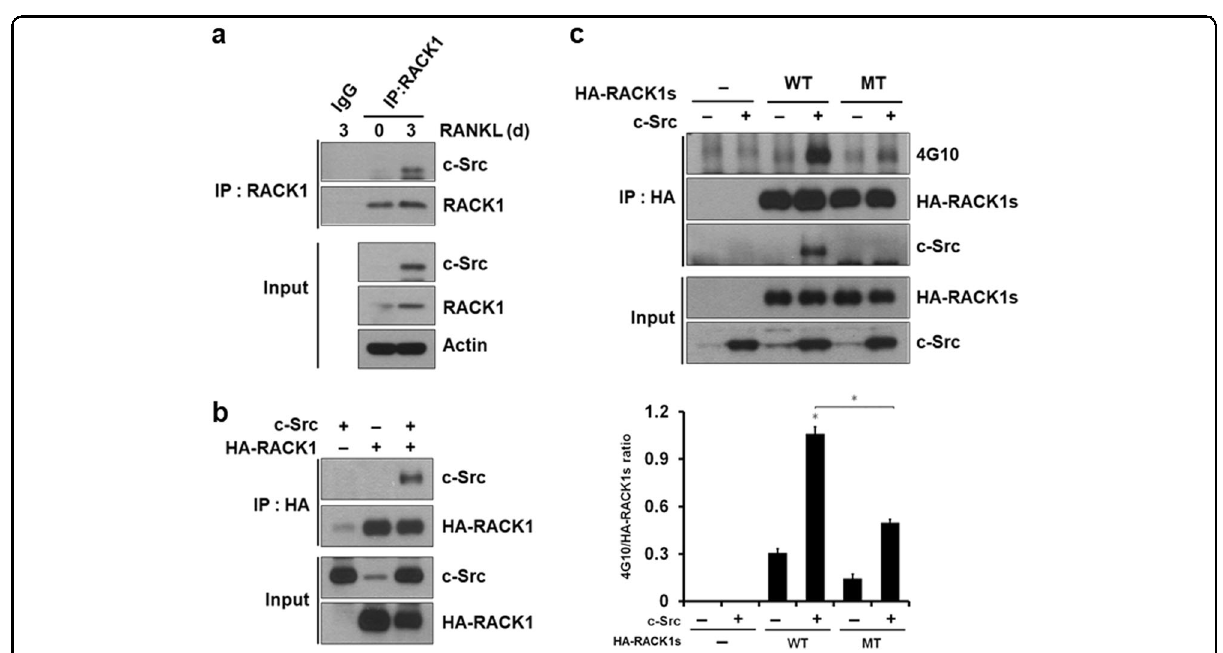
Fig. 2 RACK1 associates with c-Src in osteoclasts. a BMMs were incubated in the presence or absence of 100 ng/mL RANKL for 3 days. The cells were lysed, and endogenous RACK1 was immunoprecipitated using anti-RACK1. The immunoprecipitates were analyzed using western blotting with anti-RACK1 and anti-c-Src. b First, 293T cells were transfected with plasmids expressing HA-RACK1 or c-Src as indicated. RACK1 was immunoprecipitated using anti-HA, and the immunoprecipitates and cell lysates were analyzed using western blotting with the indicated antibodies. The levels of exogenously expressed HA-RACK1 and c-Src in the cell lysates (Input) were assessed using western blotting. c The 293T cells were transfected with the indicated expression vectors. RACK1 was immunoprecipitated from cell lysates using anti-HA. The precipitated complexes and cell lysates were analyzed using western blotting with antibodies speci fi c for the indicated proteins. The ratio of 4G10 to HA-RACK1 was quanti fi ed in each of three independent experiments. * P < 0.01, ** P < 0.05. Western blots in a – c are representative of three independent